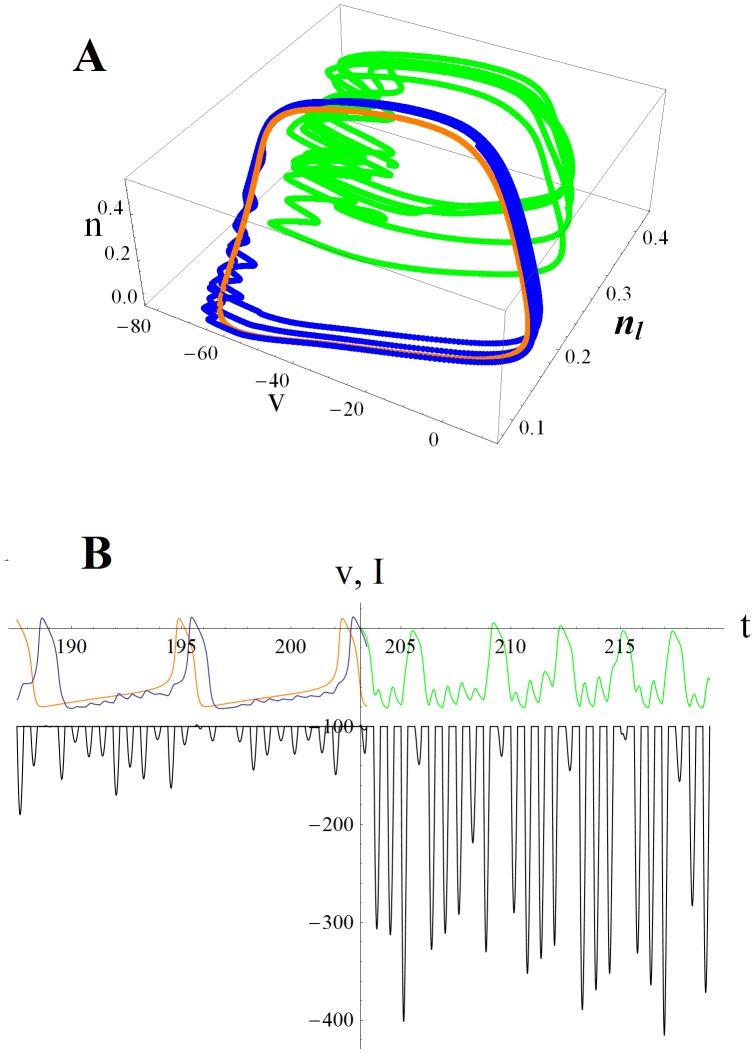
ANF spike generator modeled as a 3d version of a SNIC bifurcation.A. Spiking trajectories are shown for small (N  = 2 blue) and large (N  = 20 green) noisy periodic input currents. For comparison a trajectory driven only by increasing H conductance by 50% is shown (orange). v is membrane potential, n is the open probability of the high threshold voltage-gated potassium conductance (usually referred to as the delayed rectifier) and nl the open probability of the low threshold voltage-gated potassium conductance (negative feedback that slows the rate of spike rate increase). B. Spike trains for the same small input (blue) and large input (green) cases. Synaptic AMPA input currents (black) that correspond to an average of N vesicles released by the inner hair cell per sound wave cycle are given by a Poisson random variable. H current driven spike train is in orange. Experiments show that H can be altered by cholinergic feedback from the olive via a second messenger pathway [10]. Feedback control of H would be able to generate spike trains similar to those caused by synaptic input.